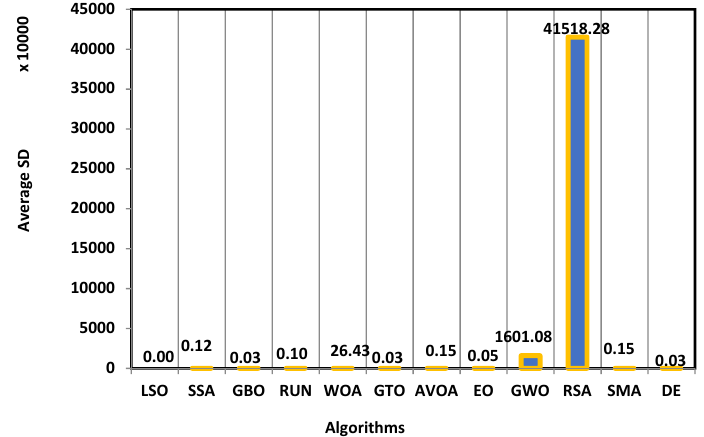
Figure 14. Average SD of each optimizer on all CEC2020. Table 13. p -values of LSO with each rival optimizer on CEC - 2020 test suite (F80-F89).